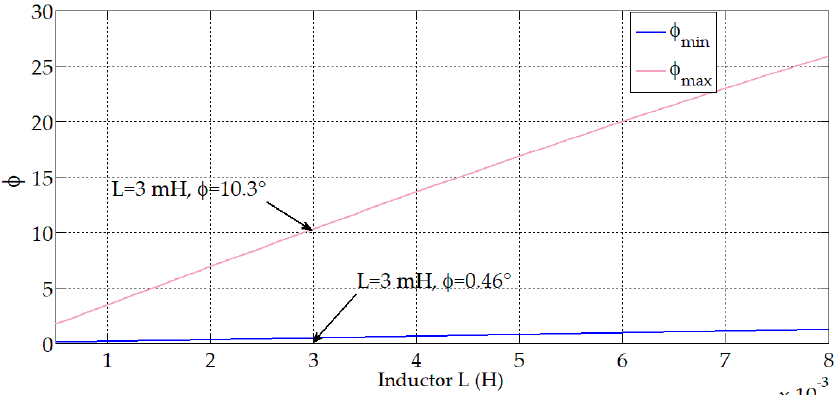
Figure 11. Phasorial diagram for the AC-DC converter operation.